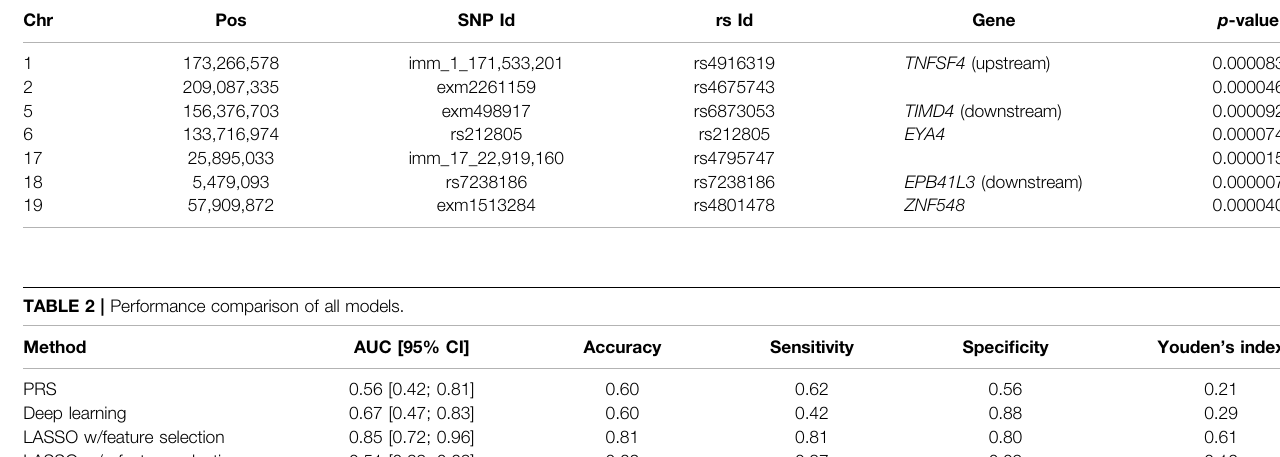
TABLE 1 | PPMI GWAS results identi fi ed seven SNPs with a p -value < 10 – 4 . Positions and rs IDs according to Human Genome Reference hg19 (GRCh37). SNP Id rs Id